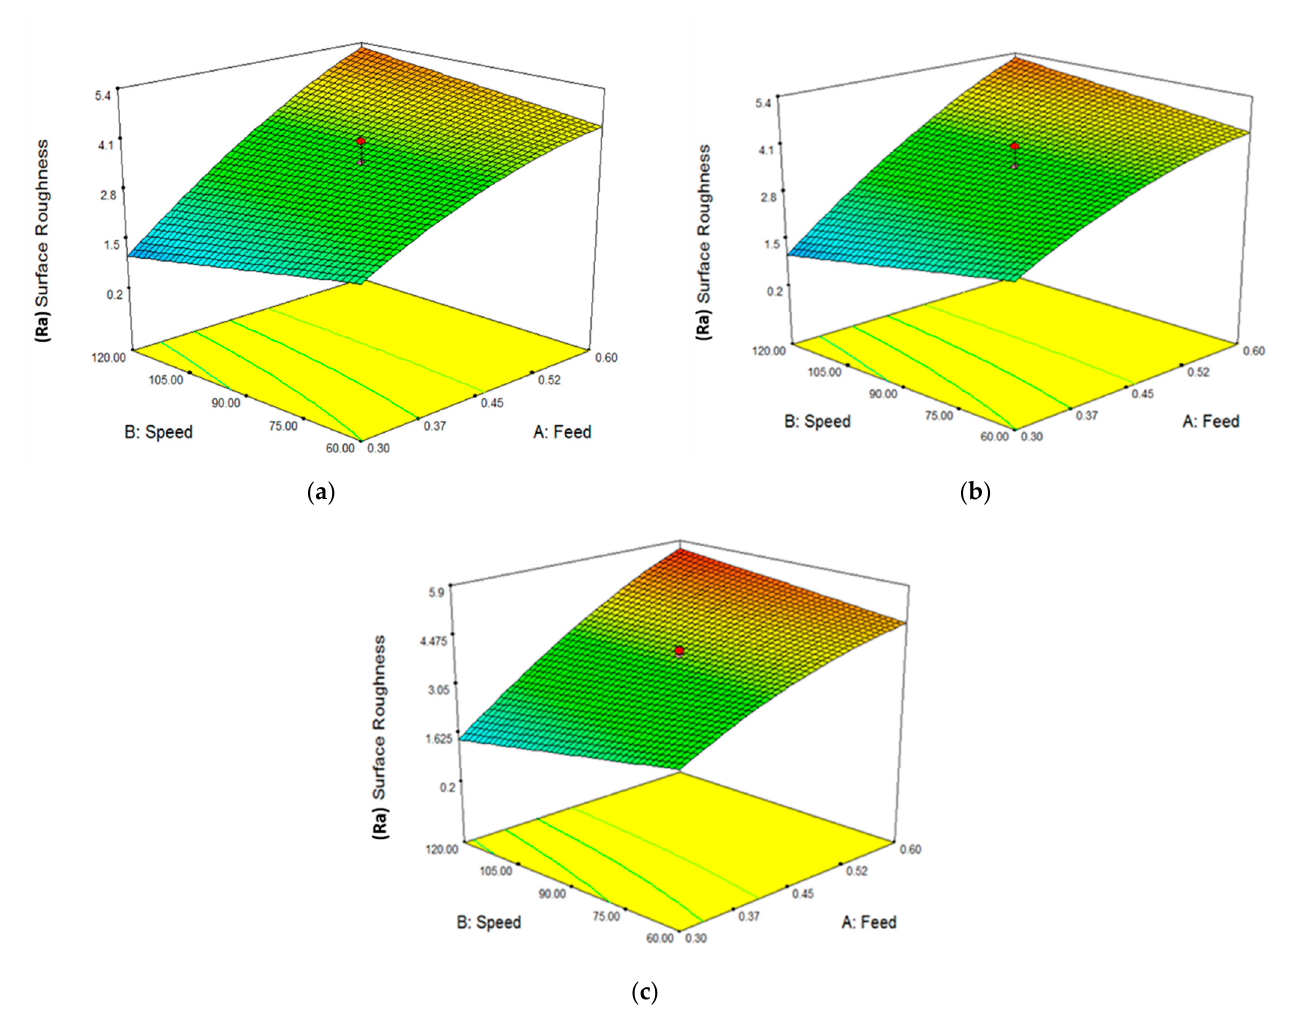
Figure 2. ( a ) 3D graph of rotational speed vs. feed for surface finish (level 1), ( b ) 3D graph of rotational speed vs. feed for surface finish (level 2), and ( c ) 3D graph for rotational speed vs. feed (level 3).